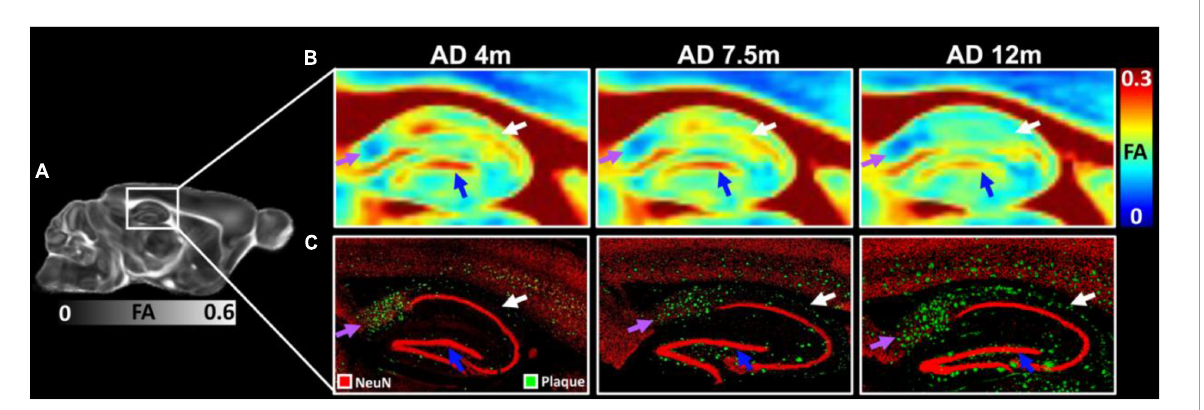
FIGURE6 The FA images (A,B) and beta-amyloid staining (C) at different ages of 5xFAD in hippocampus region. The FA values showed strongly age-dependent in the dentate gyrus (DG, blue arrows), the dorsal subiculum (DS, purple arrows), and the CA2 (white arrows). The plaques gradually increased with age in the hippocampus regions (C) .